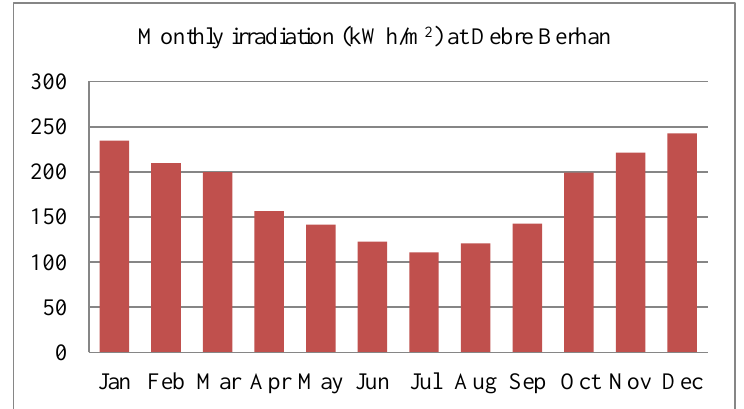
Figure 13. Solar radiation assessment of North Shewa zone at Debre Berhan.